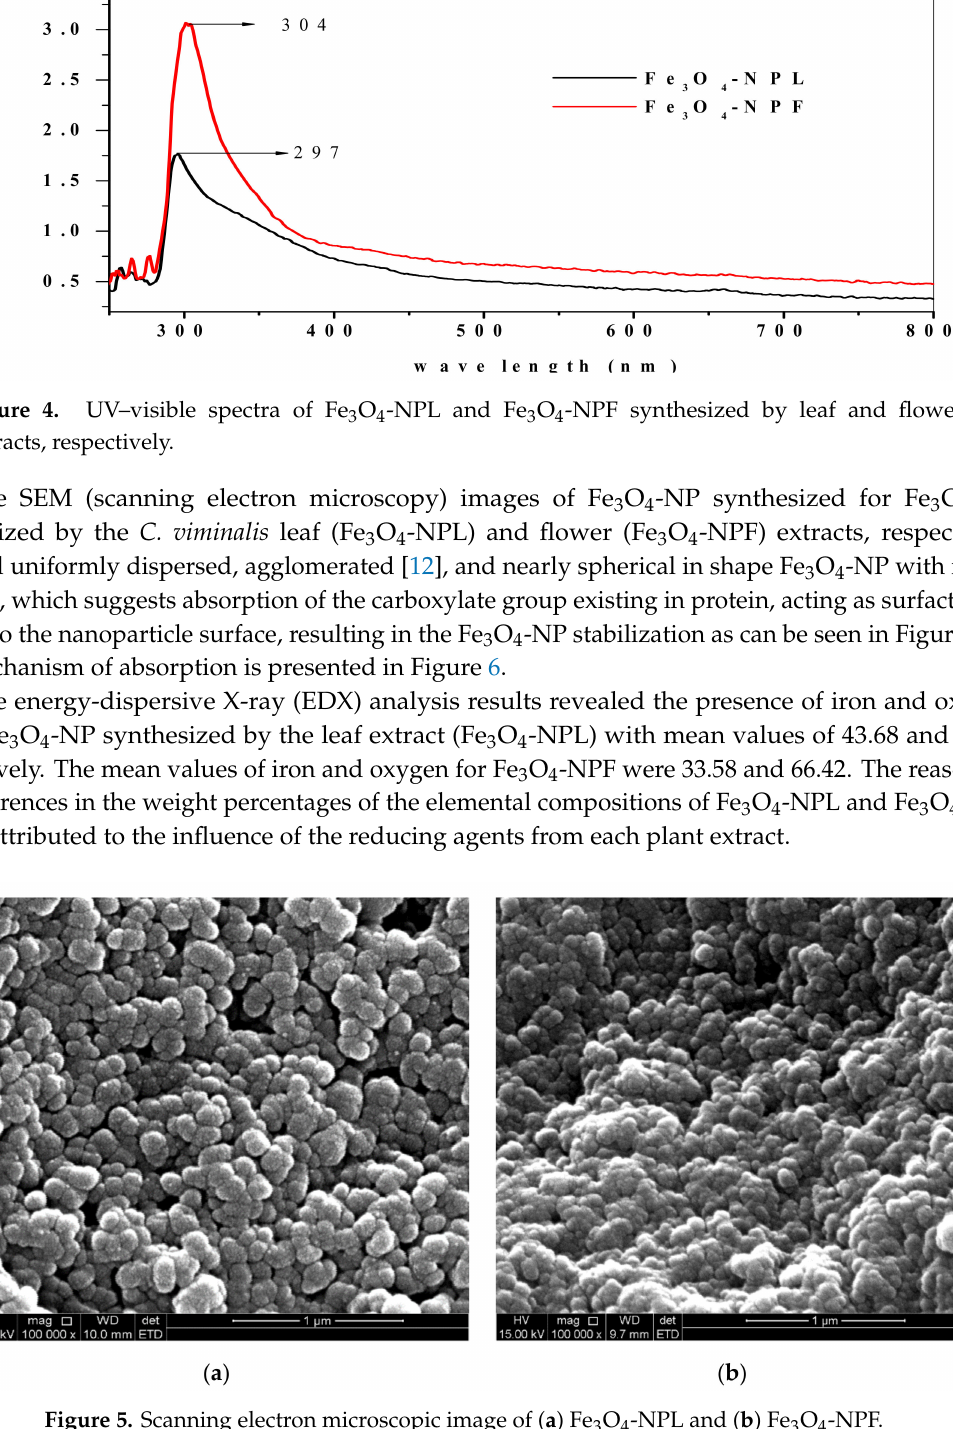
Figure 5. Scanning electron microscopic image of ( a ) Fe 3 O 4 -NPL and ( b ) Fe 3 O 4